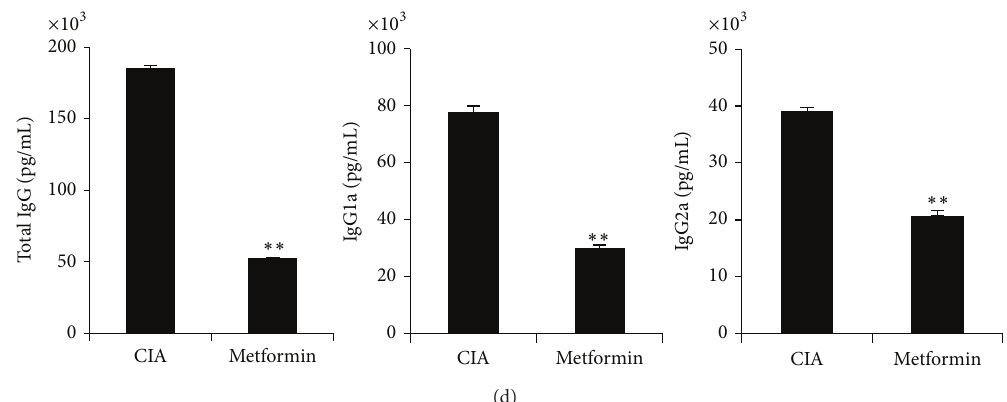
Figure 1: Therapeutic effects of metformin in CIA model. CIA was induced in C57BL/6 mice. Metformin 5 mg/mice ( 𝑛 = 10 ) or saline ( 𝑛 = 10 ) was oral feed three times into CIA in a week. Mice were sacrificed on day 70 after first immunization. (a) Clinical arthritis scores were determined. (b) The joint tissues from CIA: metformin-treated CIA mice were stained with H&E, safranin O, and toluidine blue (original magnification, × 200). The average histopathological score is shown in bar graphs (below) (scale bar = 100 𝜇 m). (c) Immunohistochemical detection of IL-17, IL-6, and TNF- 𝛼 was stained in the synovium of CIA and metformin-treated CIA. All tissues were counterstained with hematoxylin (original magnification, × 400). All images were obtained for each mouse ( 𝑛 = 10 ), showing representative images (scale bar = 50 𝜇 m). (d) Mice serum was obtained on day 30 after CII immunization. The serum obtained after first immunization. The levels of IgG, IgG1, and IgG2a antibodies were measured from each group. Mean ± SD of three independent experiments ( ∗ 𝑃 < 0.05 ; ∗∗ 𝑃 < 0.01